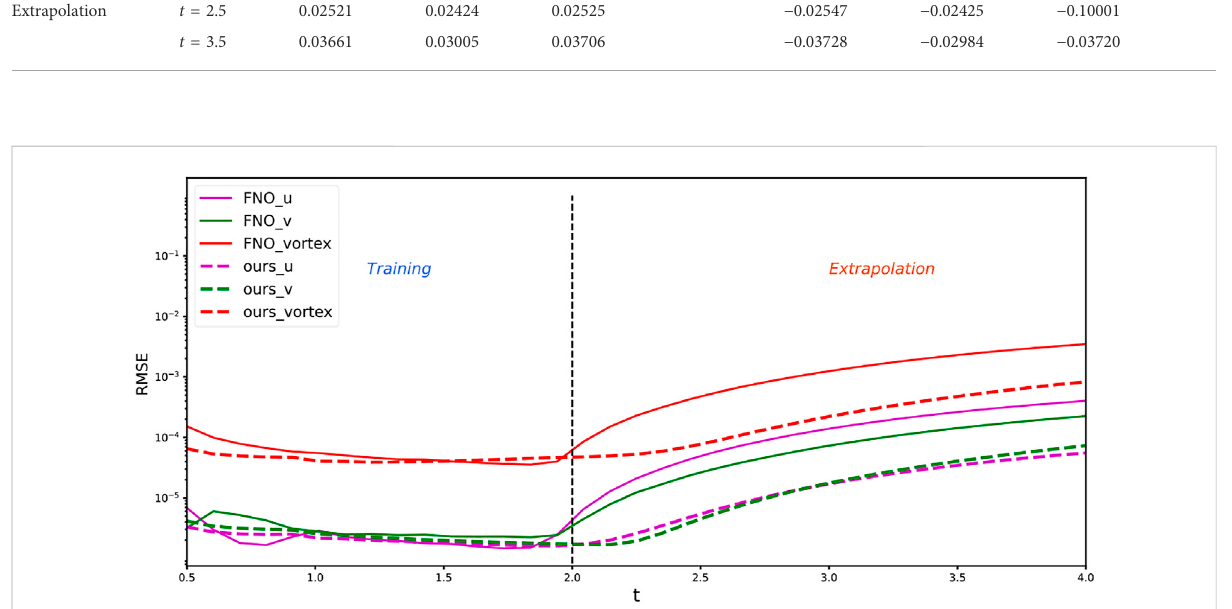
FIGURE 7 RMSE of PA_CasualLSTM- and FNO-solved 2D Navier – Stokes equations.